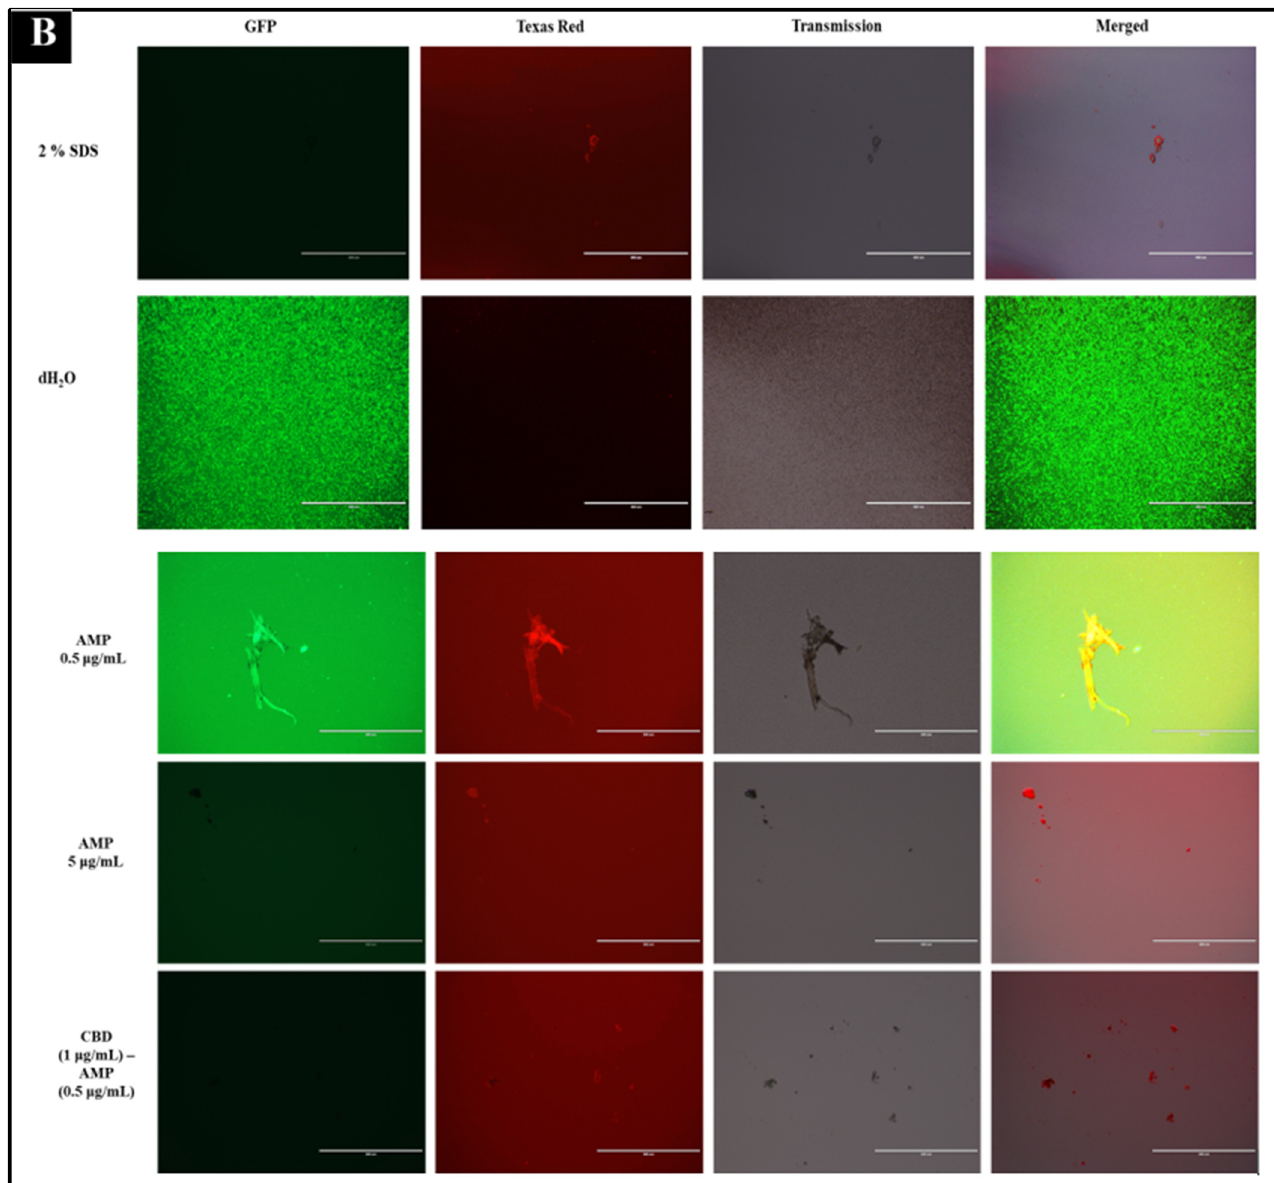
Figure 1. Synergistic analysis of ampicillin and CBD co-treatment of S. typhimurium . ( A ) Synergistic activity was observed at 0.5 μ g/mL ampicillin and 1 μ g/mL CBD co-treatment. Data presented as average OD 600 ± SEM ( B ) Immunofluorescence staining analysis positive (2% SDS) and negative (dH 2 O) controls. Immunofluorescence staining of S. typhimurium treated with ampicillin at 0.5 and 5 μ g/mL as well as the observed synergistic combination of 0.5 μ g/mL ampicillin and 1 μ g/mL CBD.